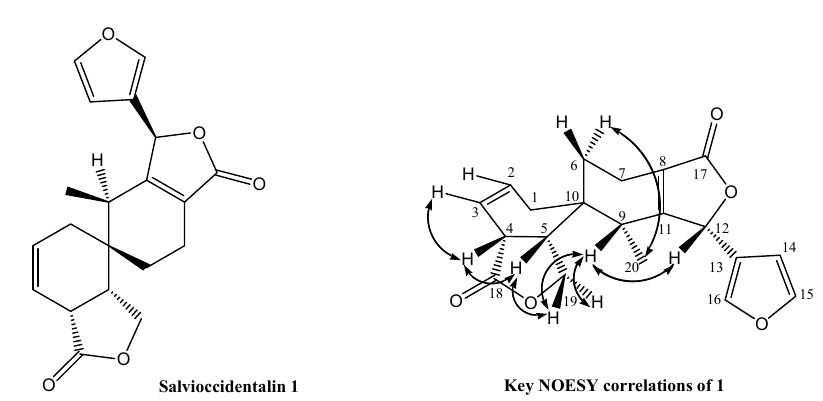
Figure 1. Salvioccidentalin ( 1